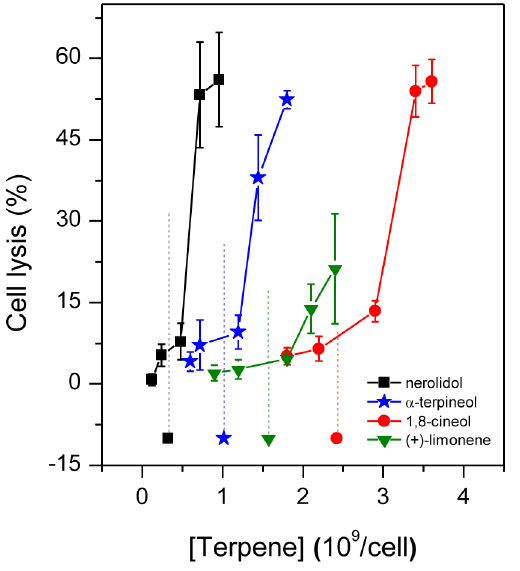
Figure 7. Percentage of cell lysis in samples of Leishmania amazonensis promastigotes treated with terpenes. The IC 50 of each terpene is represented by its corresponding symbol and a vertical